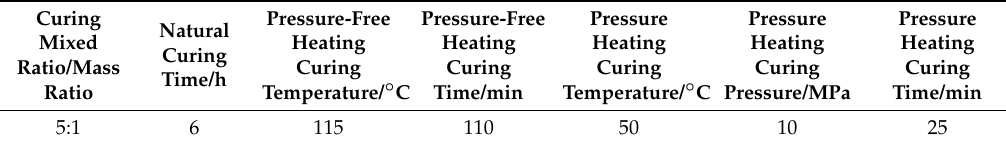
Figure 2. Process of preparing 2D-T700/E44 composite materials by ICM.